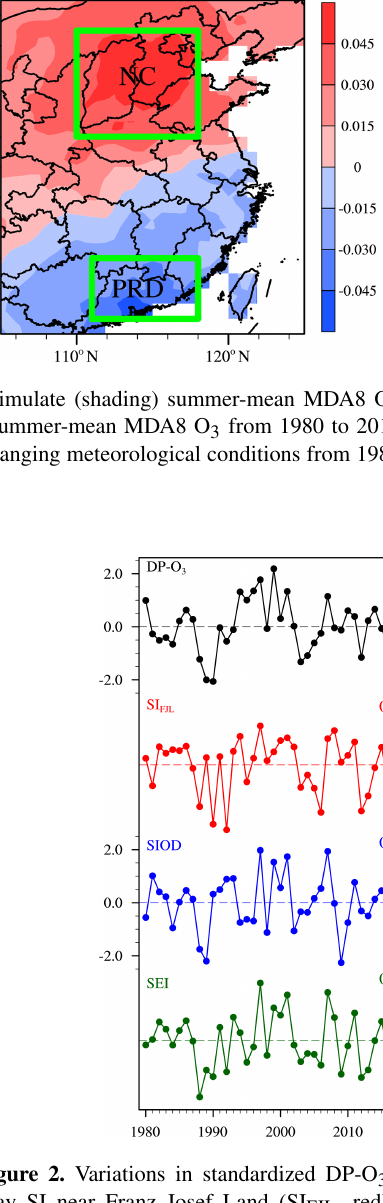
cool environment and weak solar radiation were conducive to low O 3 concentration in the PRD. On the other hand, the positive anomalies of geopotential height in NC increased surface air temperature (Fig. 3a), resulting in a dry environ- ment with decreased cloud cover and sunny weather (Fig. 3b and